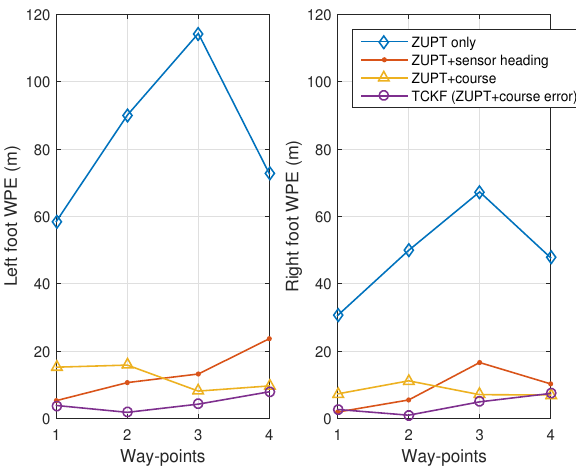
Figure 11. Way-point position errors (WPEs) for left foot and right foot.